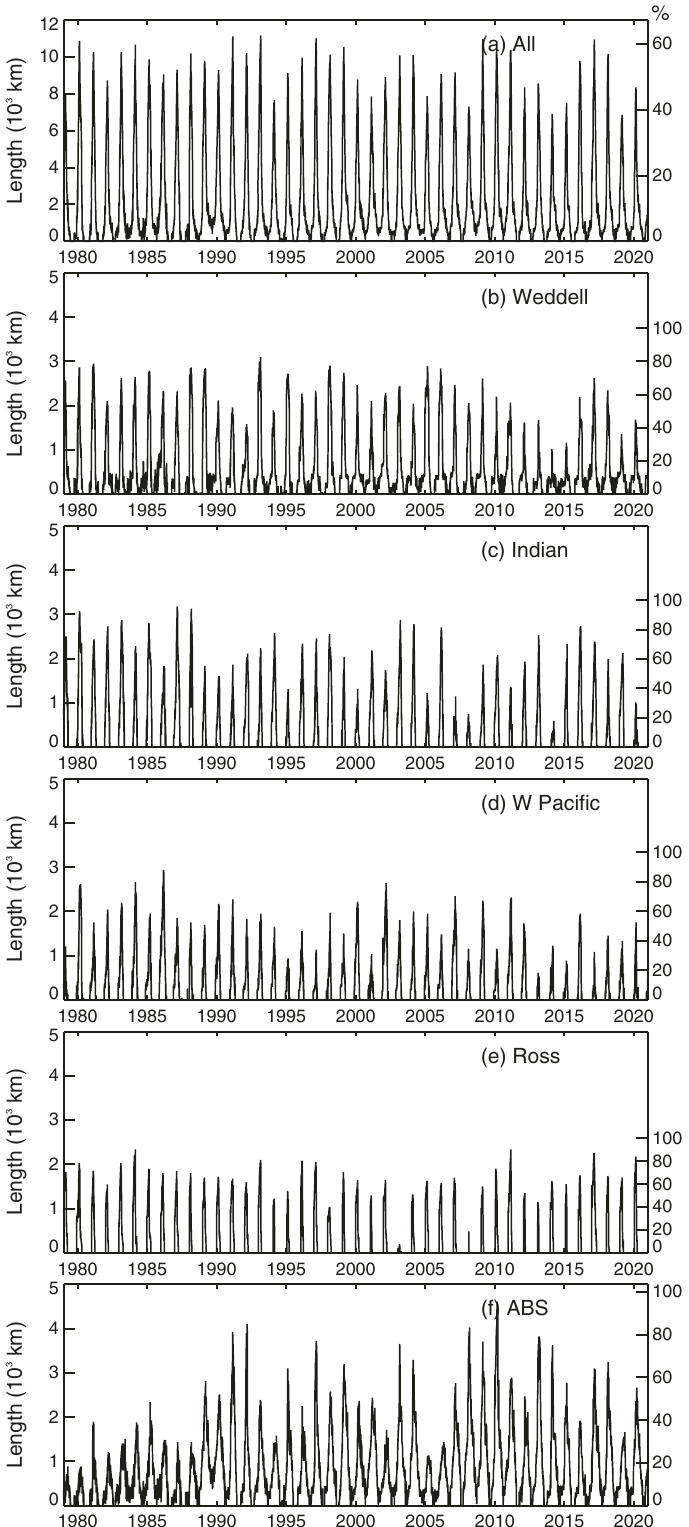
Fig. 3 Time series plots of daily coastal exposure length (in km) for 1979 – 2020. a Total Antarctic coastline, b Weddell Sea, c Indian Ocean, d W Paci fi c Ocean, e Ross Sea, and f